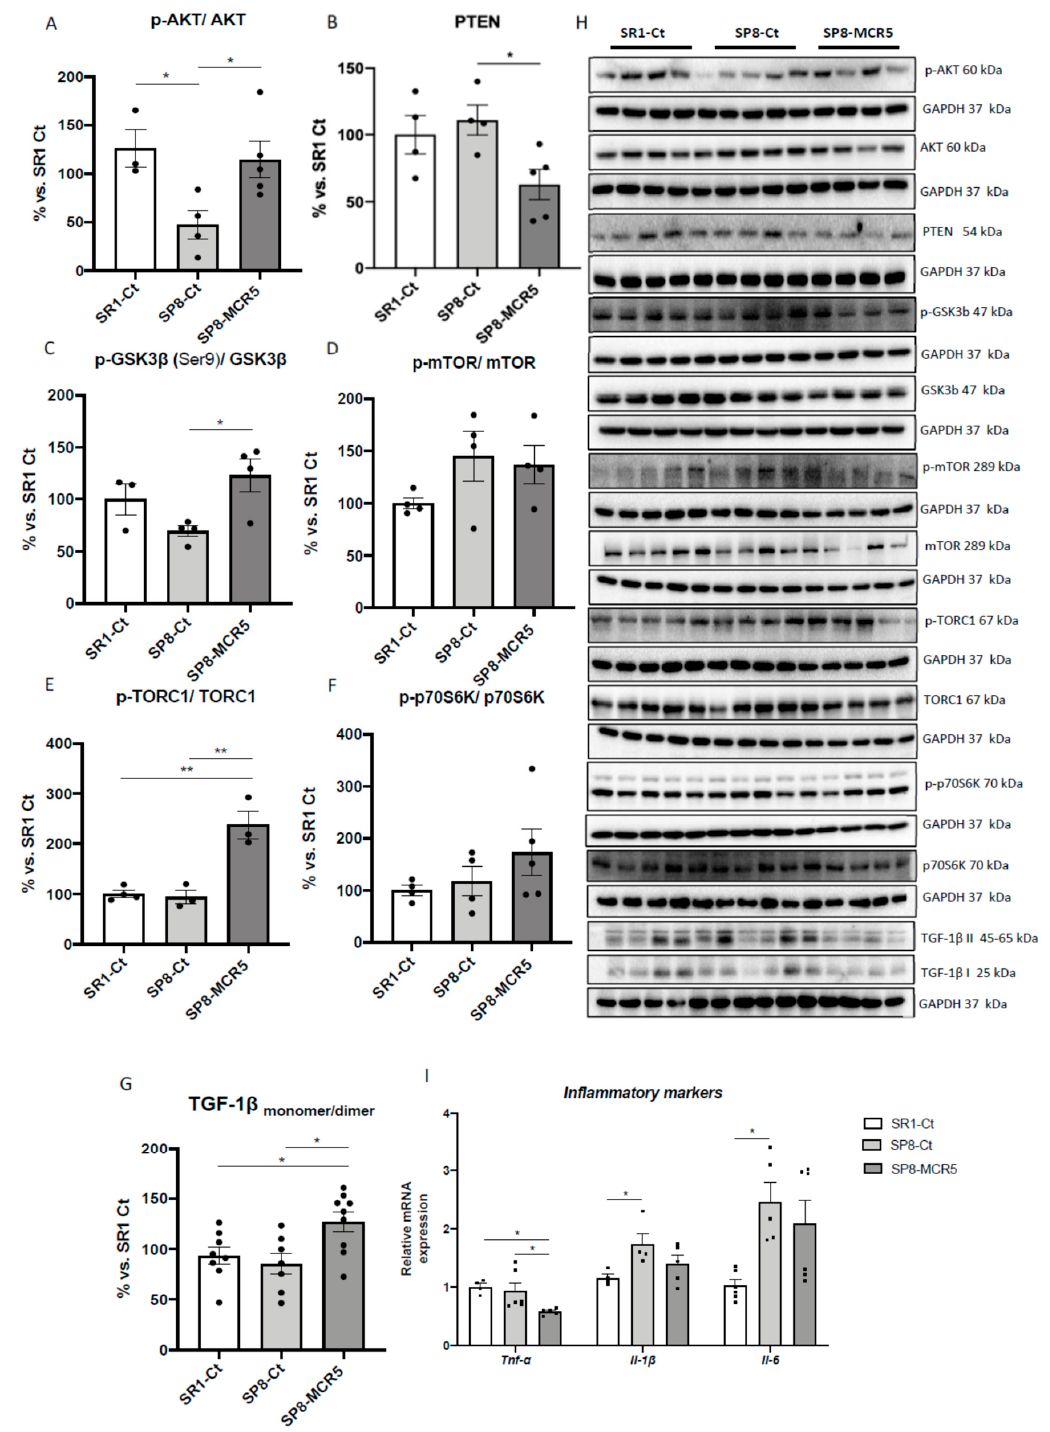
Figure 5. Representative Western blots and quantifications for the ratio of p-AKT / AKT, PTEN, ratio p-GSK3 β (Ser9) / GSK3 β , ratio p-mTOR / mTOR, ratio p-TORC1 / TORC1, p-p70S6K / p70S6K, and TGF-1 β monomer / dimer ( A – H ). Values in bar graphs are adjusted to 100% for protein levels of the control SAMR1 (SR1-Ct). Representative gene expression for Tnf- α , Il-1 β , and Il-6 ( I ). Gene expression levels were determined by real-time PCR. Values are the mean ± Standard error of the mean (SEM); ( n = 4–6 for each group). * p < 0.05; ** p < 0.01.